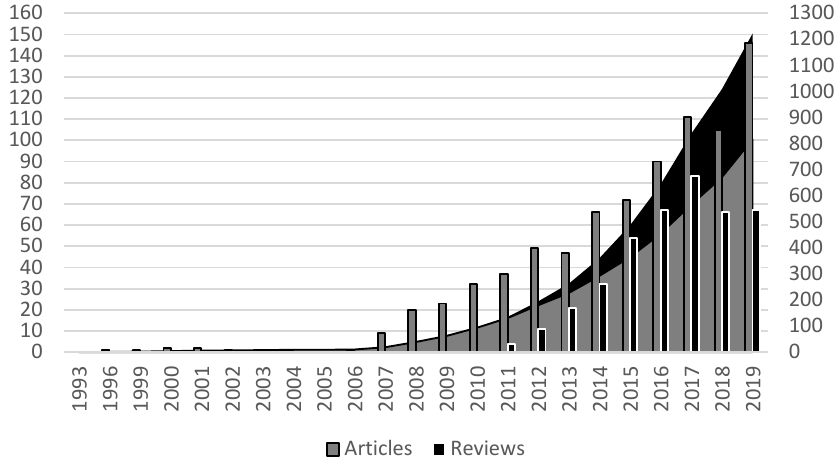
Figure 3. Cumulative value of the number of citations in residential solar heating with flat-plate solar collectors between the years 1993 and 2019.